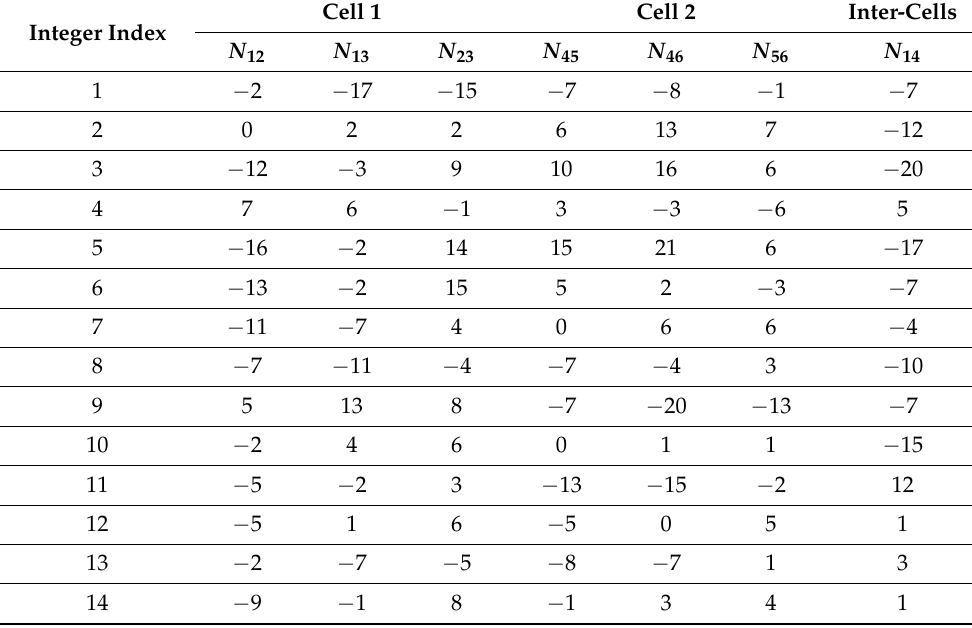
Table 2. DD integer ambiguities within the two cells and between the two master agents using a one-to-one and antenna-array RTK of the proposed framework.